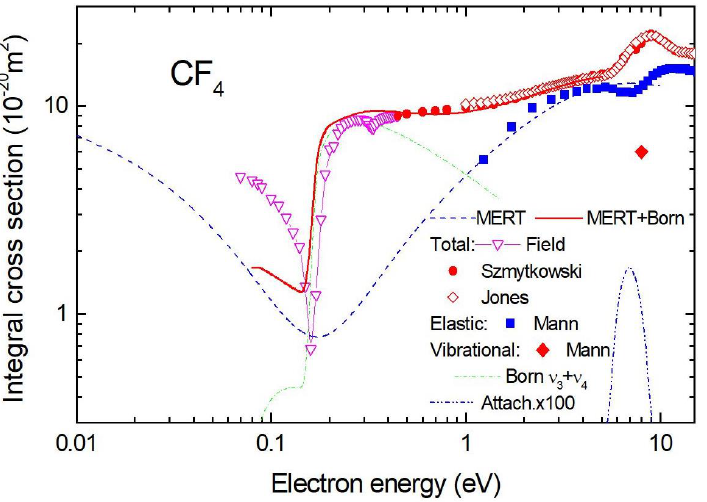
Figure 4. Integral (elastic, vibrational, total, dissociative electron attachment) cross sections for electron—CF 4 scattering in the low energy range. For references see reference